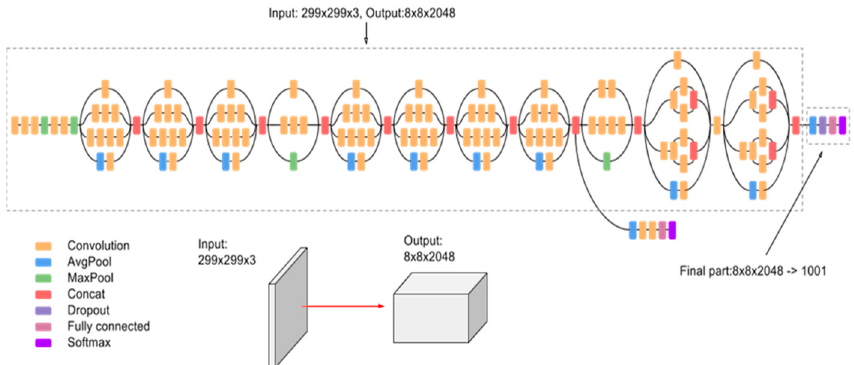
Figure 3. The Inception v3 architecture [39].